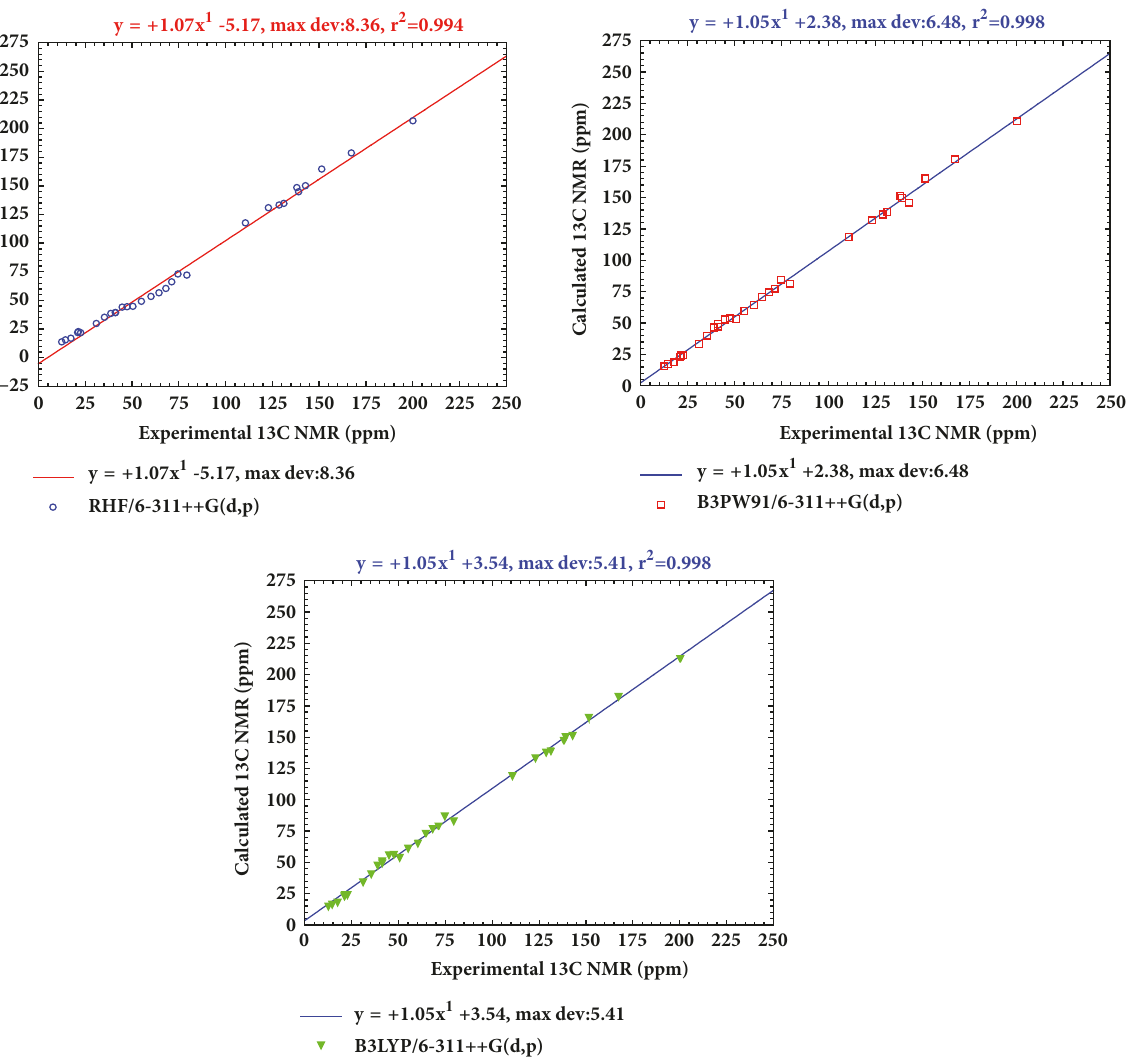
Figure 7: Comparison of experimental and theoretical 13 C chemical shifts of Rubescin E calculated at the RHF, B3PW91, and B3LYP using the 6-311++G(d,p) basis